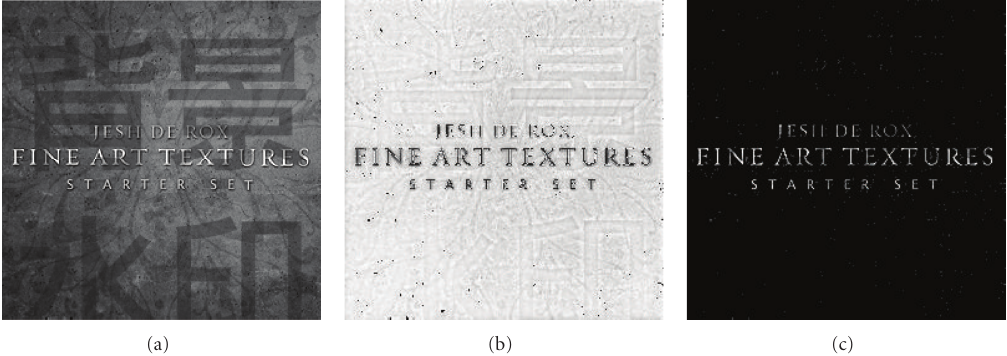
Figure 3: Extraction and separation of texts, background watermark, and textures of (a). Shown in the 3(b) and 3(c) are the image mode function and extracted texture using the proposed adaptive PDE transform.